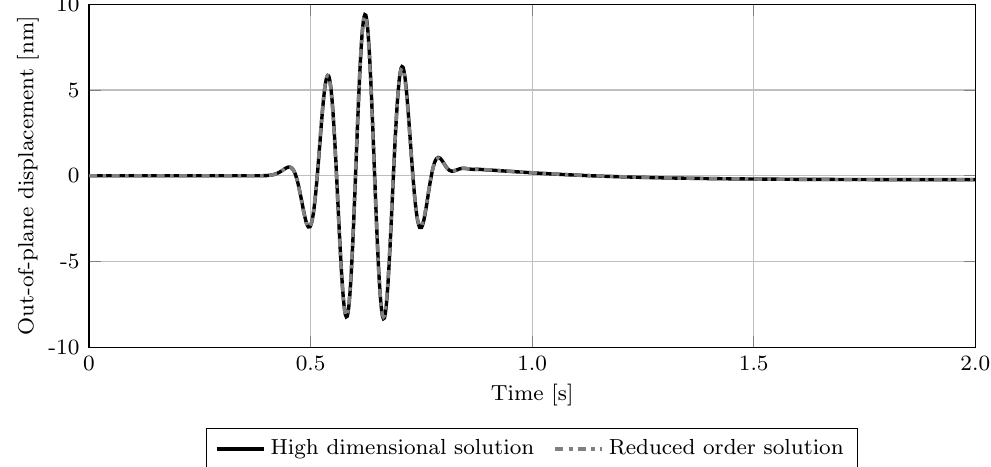
Figure 10. Comparison of high-fidelity and reduced-order solution of GUW propagation in FML.